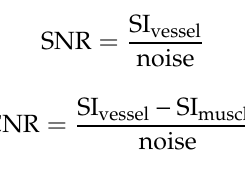
Table 1. CTPA acquisition and reconstruction parameters for hybrid-IR (AIDR 3D) and DLR (AiCE).